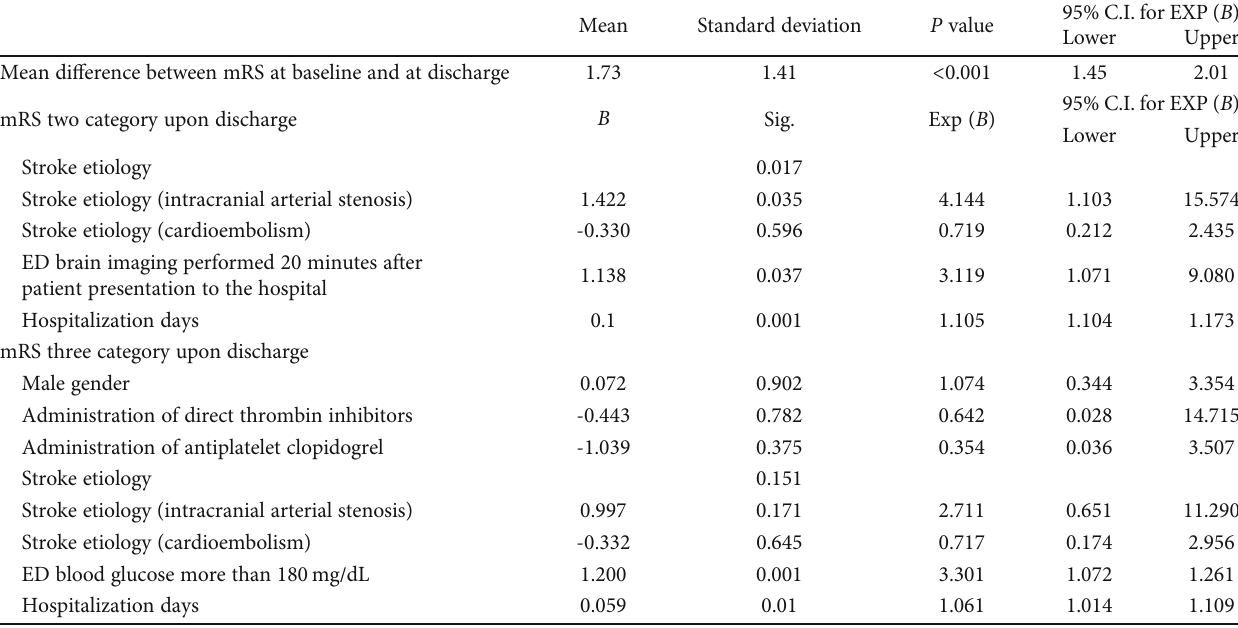
Table 7: Binary logistic regression taking mRS score upon discharge as the dependent variable and sociodemographic factors, past medical history, and medication history as the independent